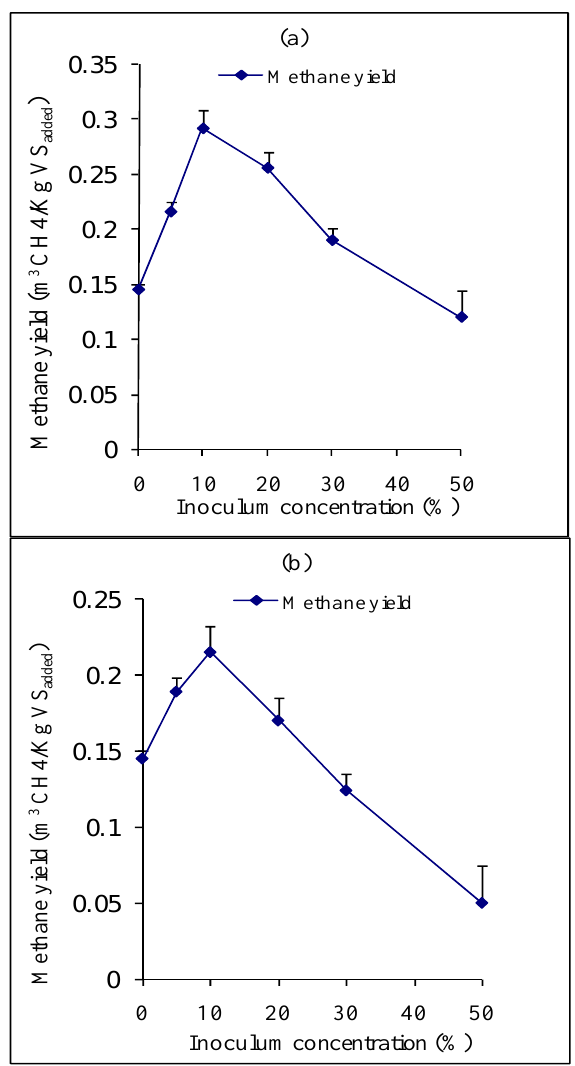
Figure 1. Methane yield of SLDR after two-steps pre-treatment with (a) 10% CCHT-1 inoculum followed by different T. reesei inocula concentrations (% wet weight of SLDR), (b) 25% T. reesei followed by different CCHT-1 inocula concentrations (% wet weight of SLDR).